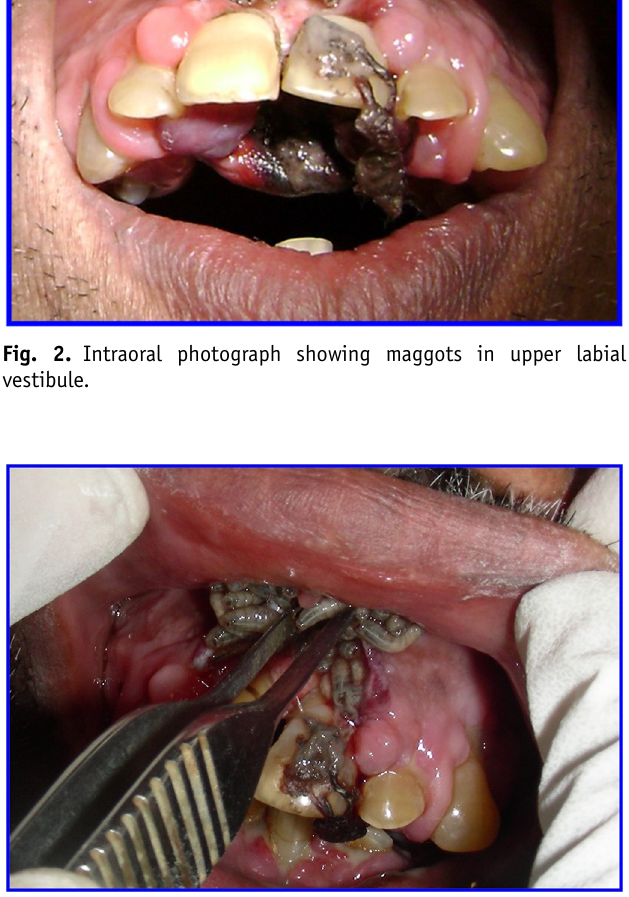
Fig. 3. Mechanical removal of